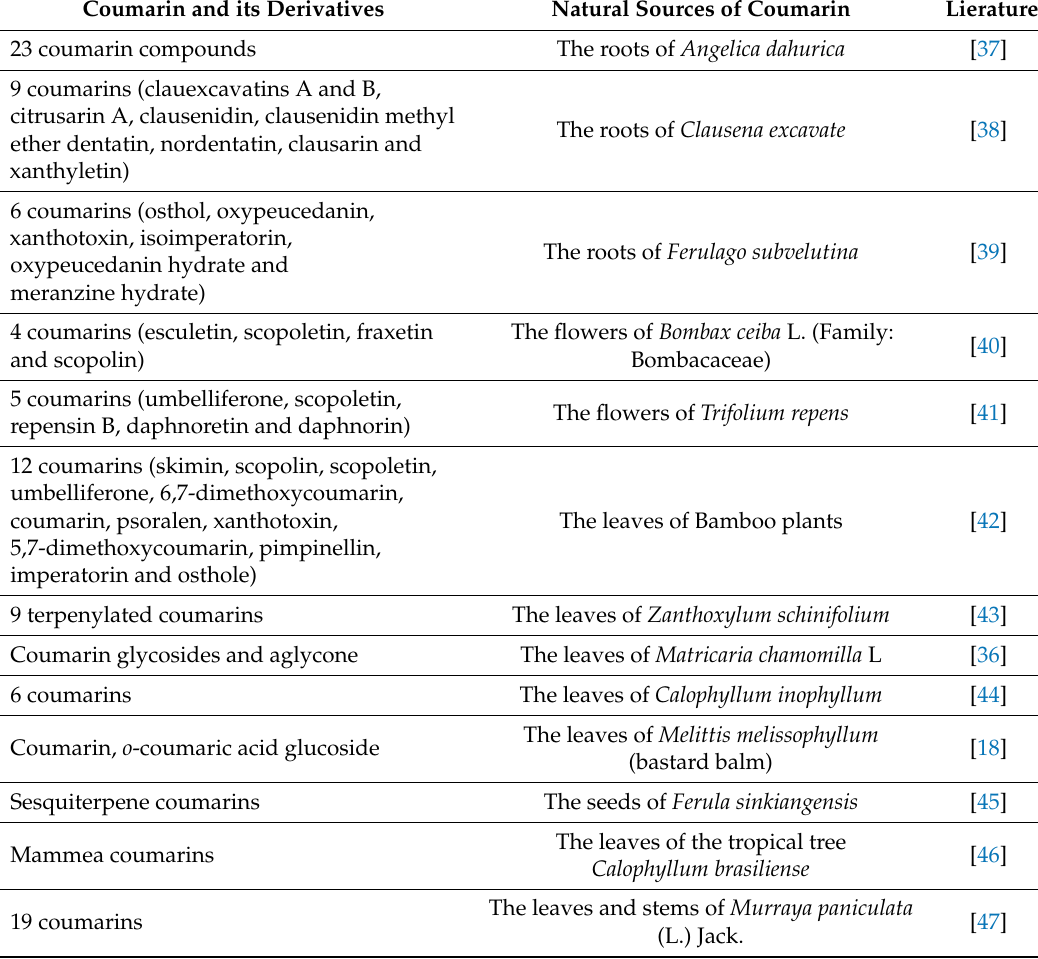
Table 2. Some of the natural sources of